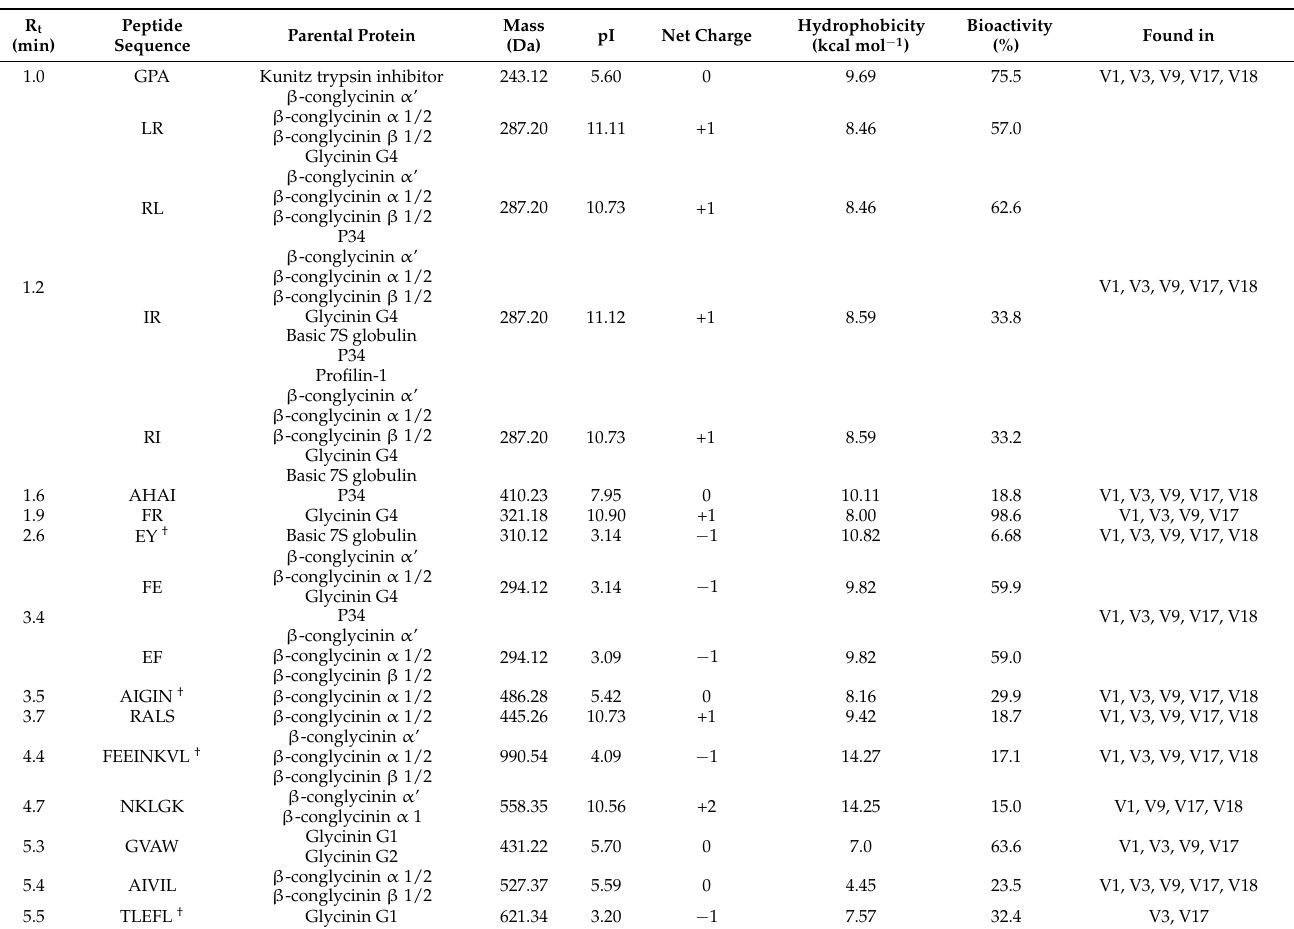
Table 1. Peptides identified in selected soybean varieties digests and their physicochemical and potential biological properties ‡